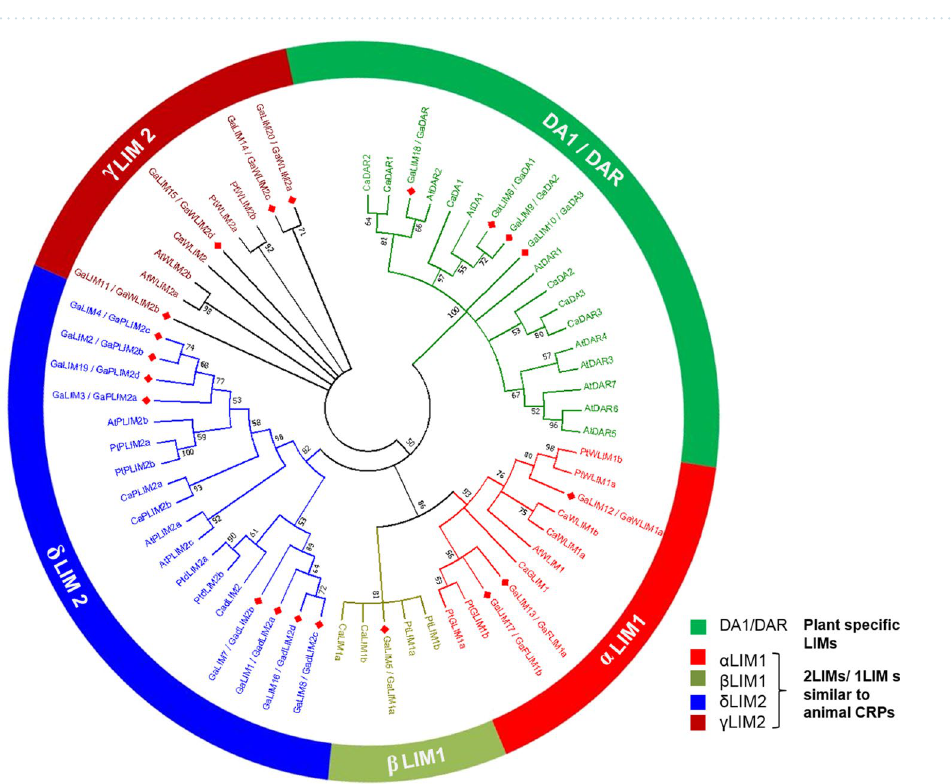
Figure 3. Maximum likelihood tree representing evolutionary relationship of the identified GaLIMs compared with LIMs from Arabidopsis, Poplar and Chickpea (MEGA v.7.0 software; https:// www. megas oftwa re.